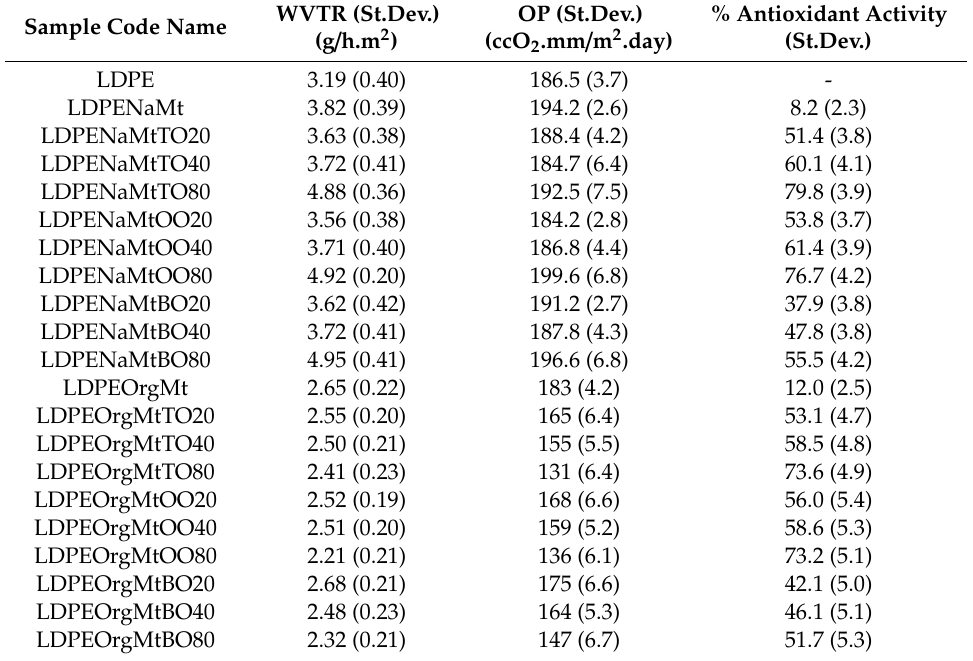
Table 2. Mean (standard deviation) values of water / oxygen barrier properties and % di(phenyl)- (2,4,6-trinitrophenyl) iminoazanium (DPPH) oxidation after 24 h of all LDPENaMtEO and LDPEOrgMtEO nanocomposite films, as well as of the LDPENaMt, LDPEOrgMt, and the pure LDPE film.